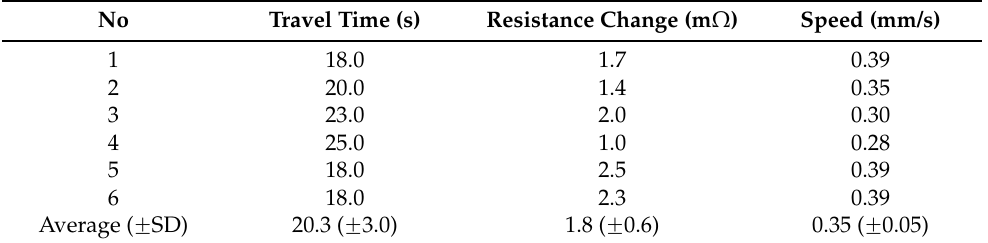
Table 1. Measurement result of the travel time and change in resistance. SD: Standard